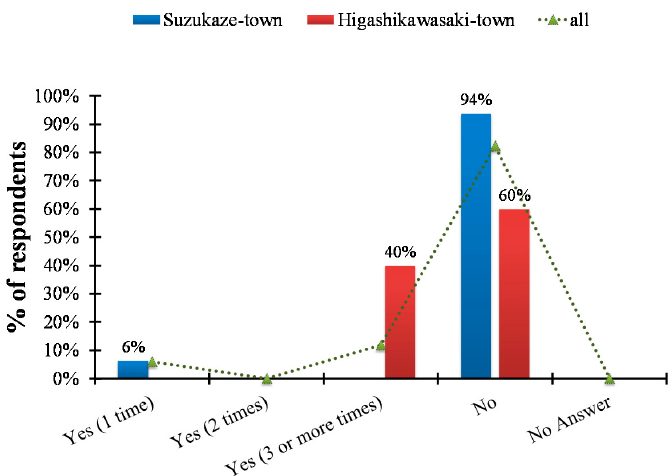
Figure 12. Proportion of respondents who have experienced some sort of damage from a previous storm surge (n = 5 for Higashi-Kawasaki town, n = 12 for Suzukaze town).